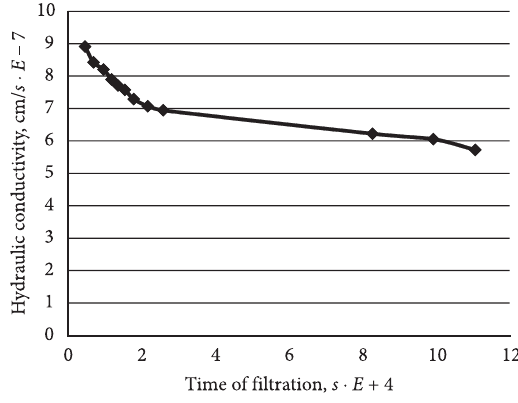
cycleFig. 7. Variations of hydraulic conductivity during the second filtering stage after the second freeze-thaw cycle